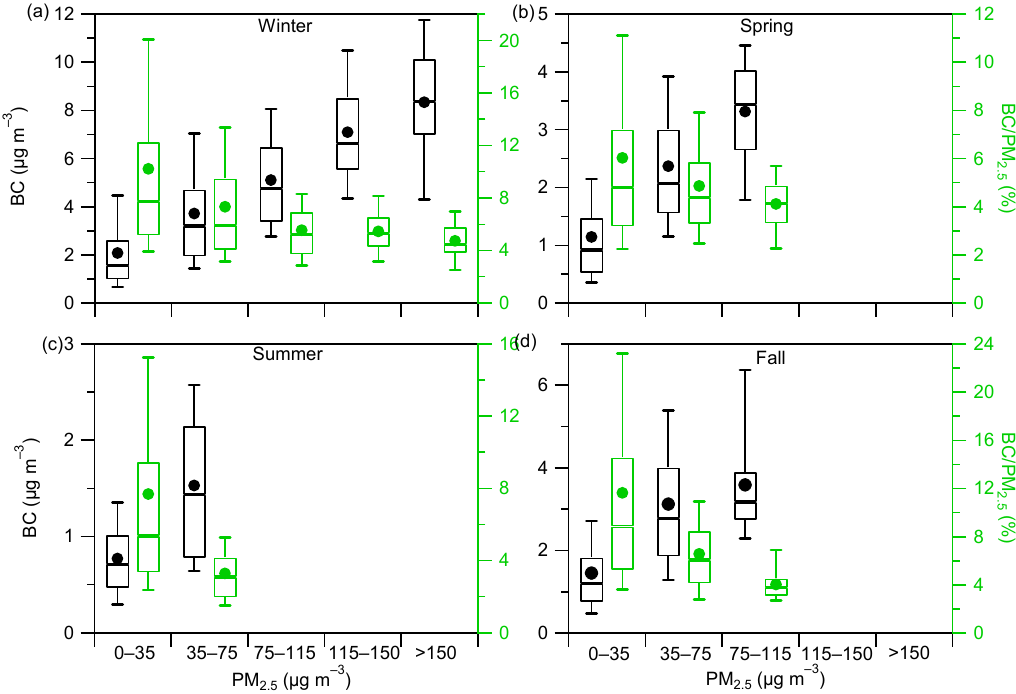
Figure 4. Mass concentrations and mass percentages of BC in PM 2.5 (atmospheric fine particulate matter with aerodynamic equivalent diameter less than 2.5 μ m) as a function of PM 2.5 in winter ( a ), spring ( b ), summer ( c ), and fall ( d ). (Meanings of the boxes are consistent with those described in Figure 2).